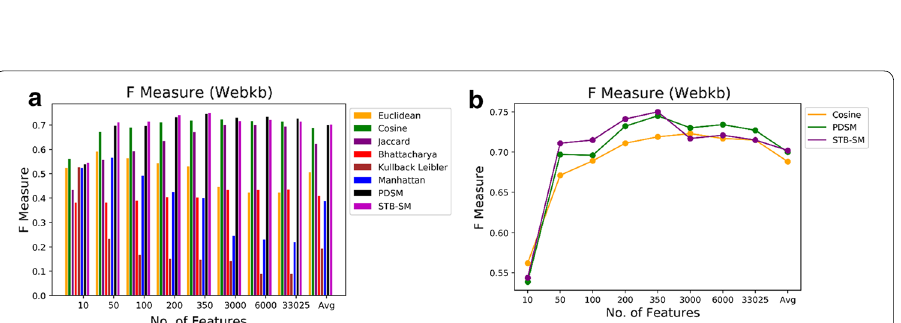
Fig. 5 a F-measure over all Measures on all NF values–average results (K over competitive measures on all NF values– Average results (K competitive measures on all NF values– Average results (K